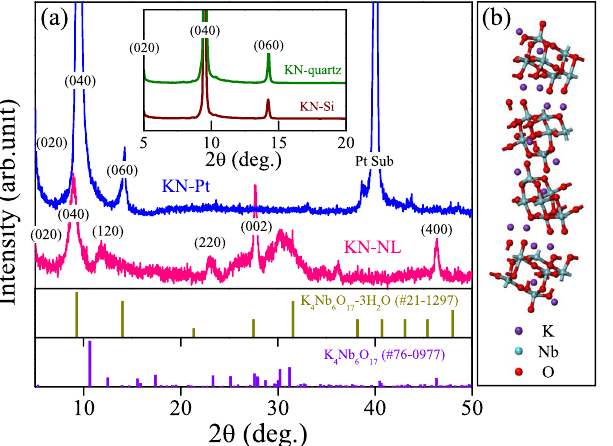
Figure 1. ( a ) XRD patterns of KN-NL, KN-Pt, KN-Si and KN-quartz films. ( b ) Simulated structures of